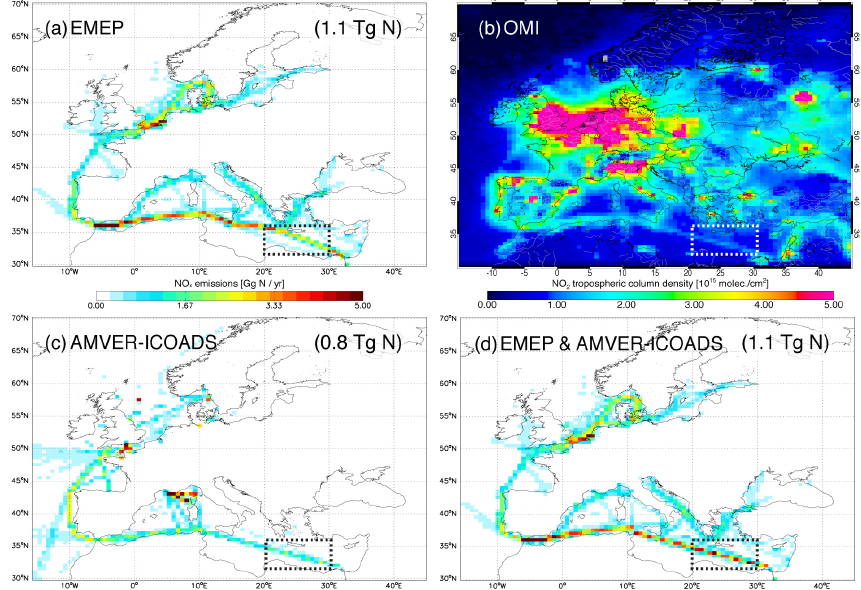
Fig. 7. EMEP (Monitoring and Evaluation of the Long-range Transmission of Air Pollutants in Europe) NO x ship emission inventory (Vestreng et al., 2007) for 2005, showing emissions in the Mediterranean Sea close to Crete ( a , black rectangle). In the AMVER-ICOADS inventory (Wang et al., 2008) for 2001 (c) , the location of emissions in the Mediterranean Sea is closer to the ship track location visible in an annual average of OMI tropospheric NO 2 columns for 2005 (b) . For this study we created a combination of the EMEP and AMVER- ICOADS inventory, replacing EMEP emissions in the Mediterranean Sea by AMVER-ICOADS emissions, scaled to the EMEP total over this area (d)